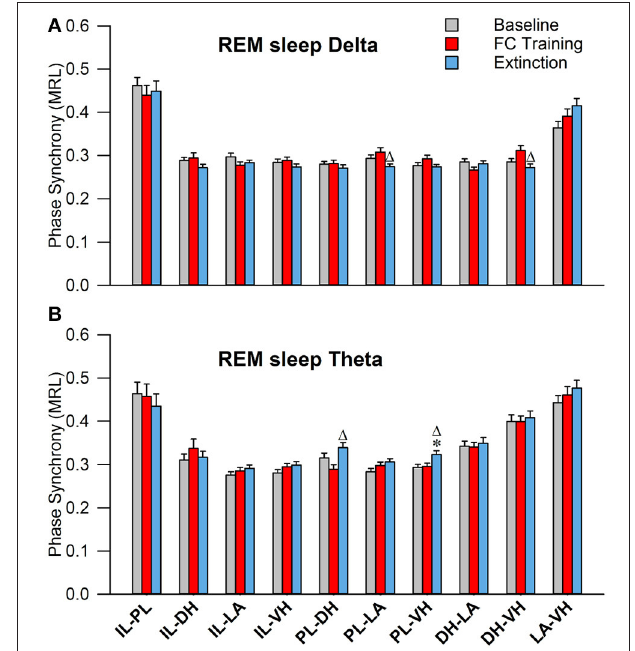
FIGURE 7 | Synchrony during REM Sleep following Fear Conditioning and Extinction. Bar plots displaying PLV of delta (A) and theta (B) synchrony during REM sleep following fear conditioning (red) and extinction (blue). In delta rhythms, PL-LA and DH-VH synchrony increased following fear conditioning, compared to extinction. In theta rhythms, PL-DH synchrony was increased following extinction, compared to fear conditioning. Additionally, PL-VH synchrony increased following extinction compared to both baseline and fear conditioning. *denotes significant difference ( p < 0.05) compared to baseline, and 1 denotes significant difference ( p < 0.05) compared to fear conditioning. PL, pre-limbic; DH, dorsal hippocampus; VH, ventral